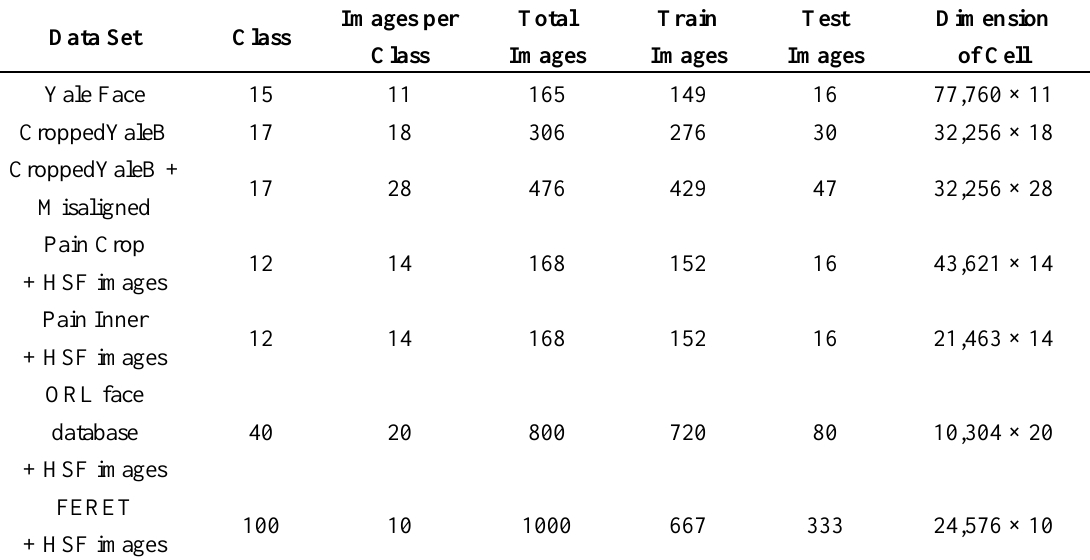
Table 1. Dataset specifications for our